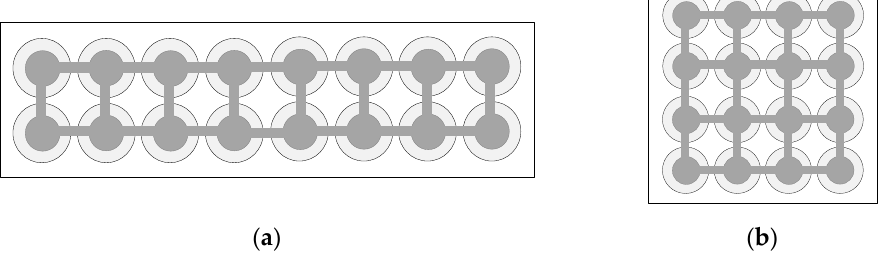
Figure 1. Capacitive micromachined ultrasonic transducer (CMUT) diagram. ( a ) Rectangular dia- gram; (b) Square diagram.